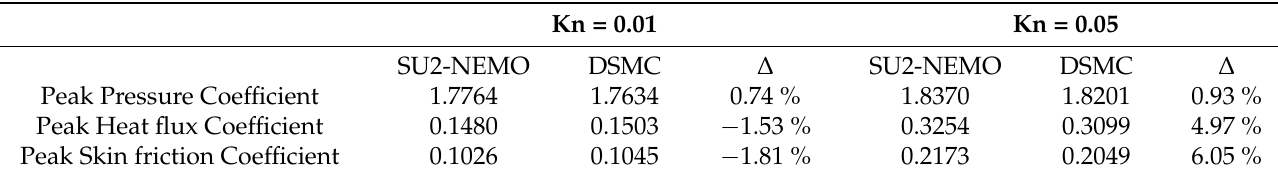
Table 8. Peak values at the surface of the